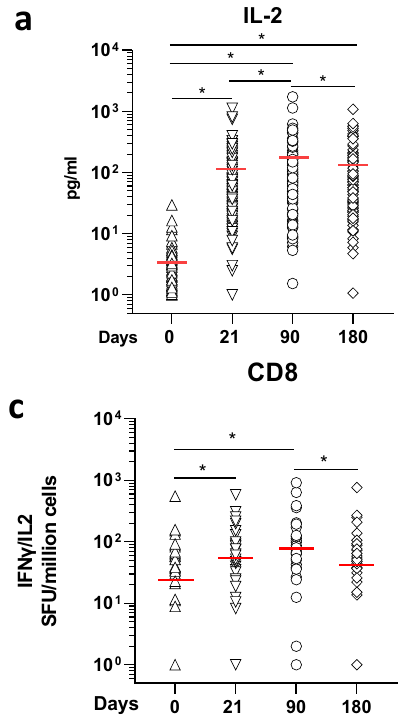
d CD4 Th1cells overtime invaccinees.T cells were assayed onasubset of vaccinees ( n =80) by IL-2/ IFN- γ ELISPOT using 9 mer or 15 mer pool peptides, respectively. Data are presented are spot forming units (SFU) per million of PBMC from paired samples from vaccinated individuals atfourtime points. Eachdata point represents thenormalizedmeanspotcountfromduplicatewellsforonestudyparticipant,after subtraction of the medium-only control. The median values of each group are representedbyaredlineandwere atday0,21, 90and 180:26.4,46.2, 55.4and 57.2 SFU for CD8 T cells; and 2, 67.25, 167.4 and 134.5 SFU for CD4 Th1 cells * p <0.01, Dunn ’ s test after Kruskal – Wallis ( p <0.001) on log-transformed